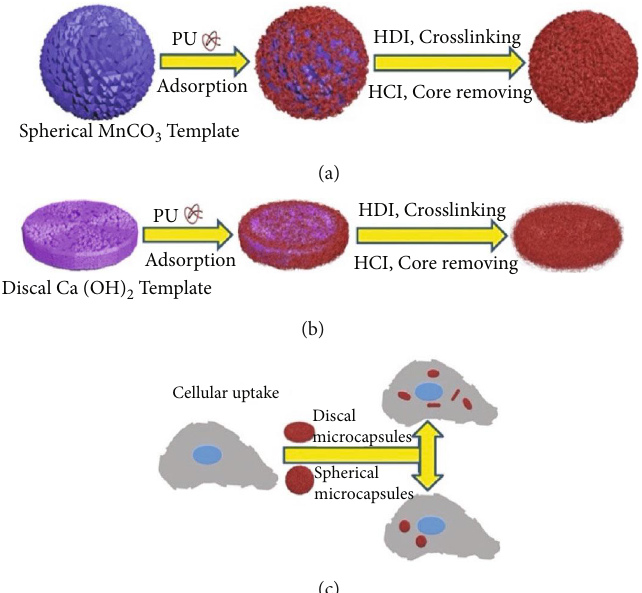
Figure 54: Fabrication process of (a) spherical and (b) discal PU microcapsules and (c) the cellular uptake of the microcapsules [149].